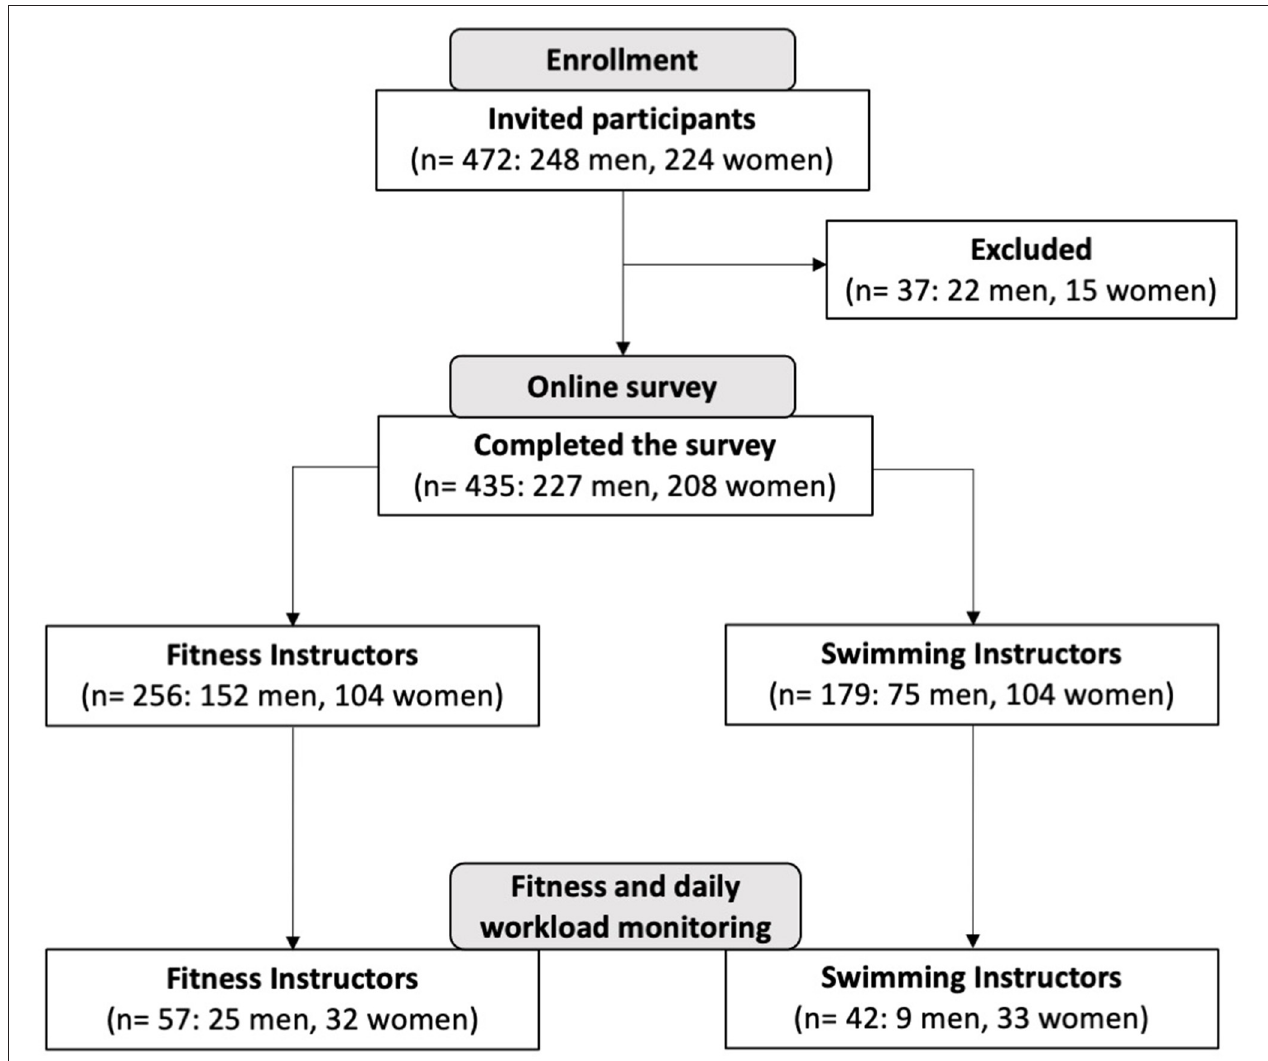
FIGURE 1 | Study flow